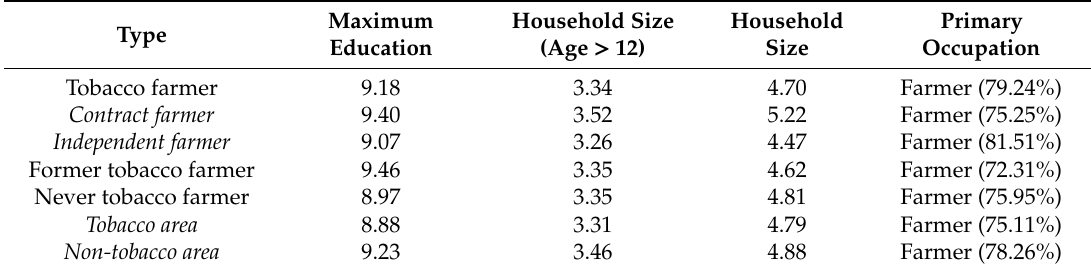
Table 2. Characteristics of the farmer